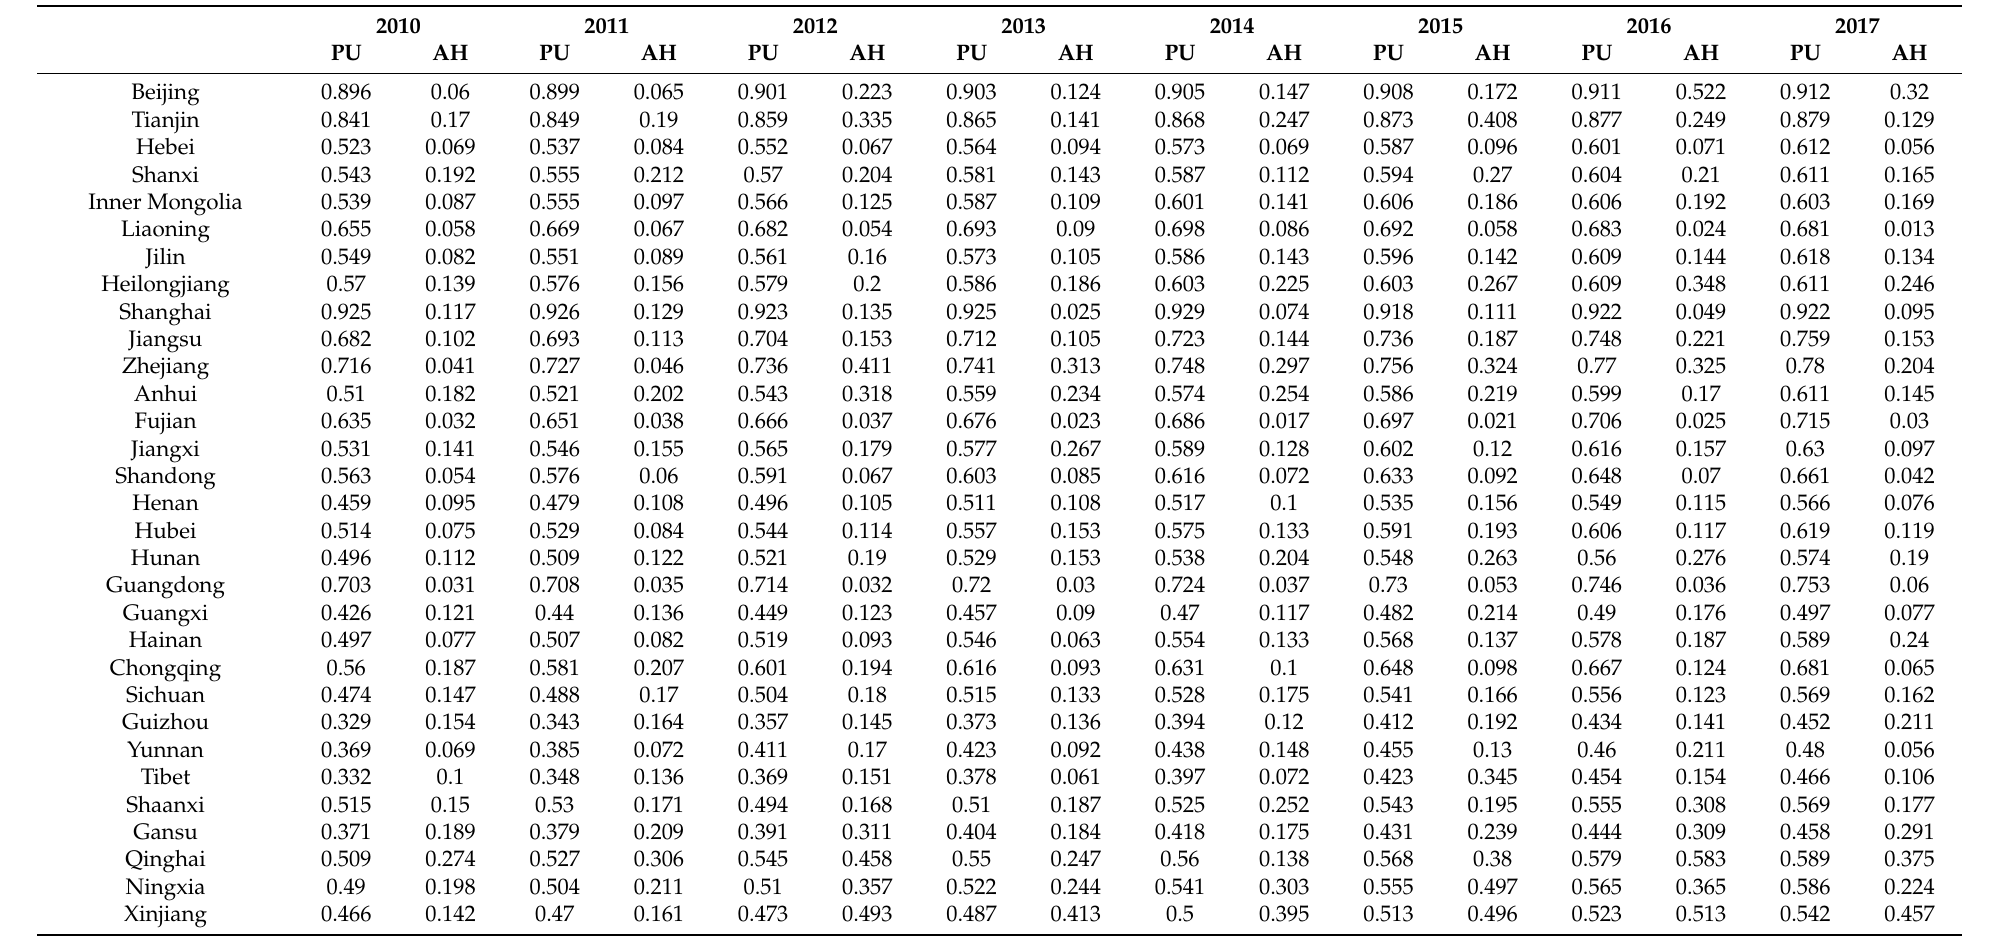
Table A1. Comprehensive evaluation index values of population urbanization (PU) and affordable housing